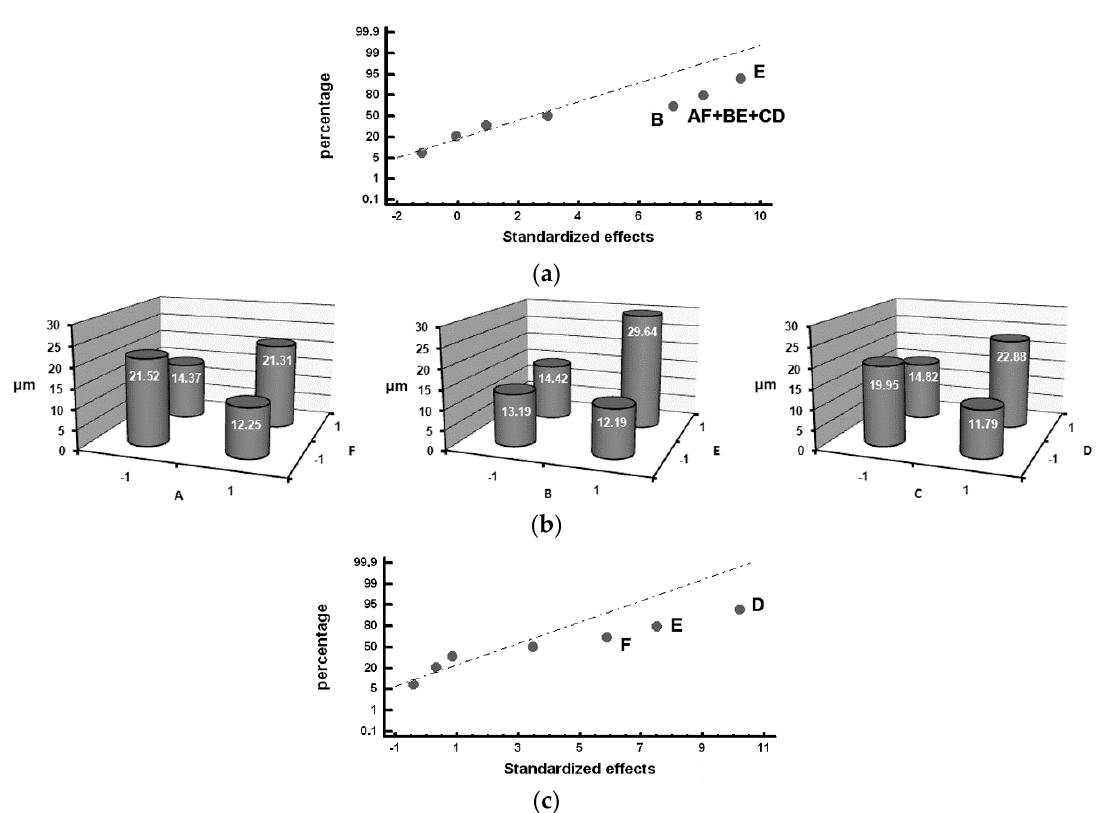
Figure 3. Standardized effects on the number of counts per mm 2 of graphite, N A , on a normal probability plot: ( a ) Factors with a significant effect on the outermost region of the working layer (Zone α ); ( b ). Factors with a significant effect on the inner region of the working layer (Zone β ).